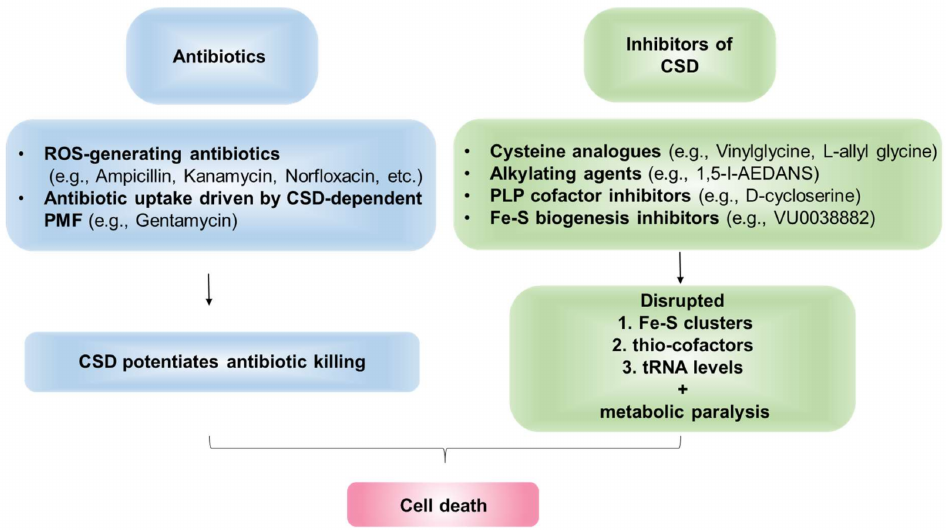
Figure 7. CSD as a drug target. CSDs mediate cellular death via potentiating the effect of existing antibiotics. Additionally, CSDs can be targeted by specific inhibitors to disrupt cellular